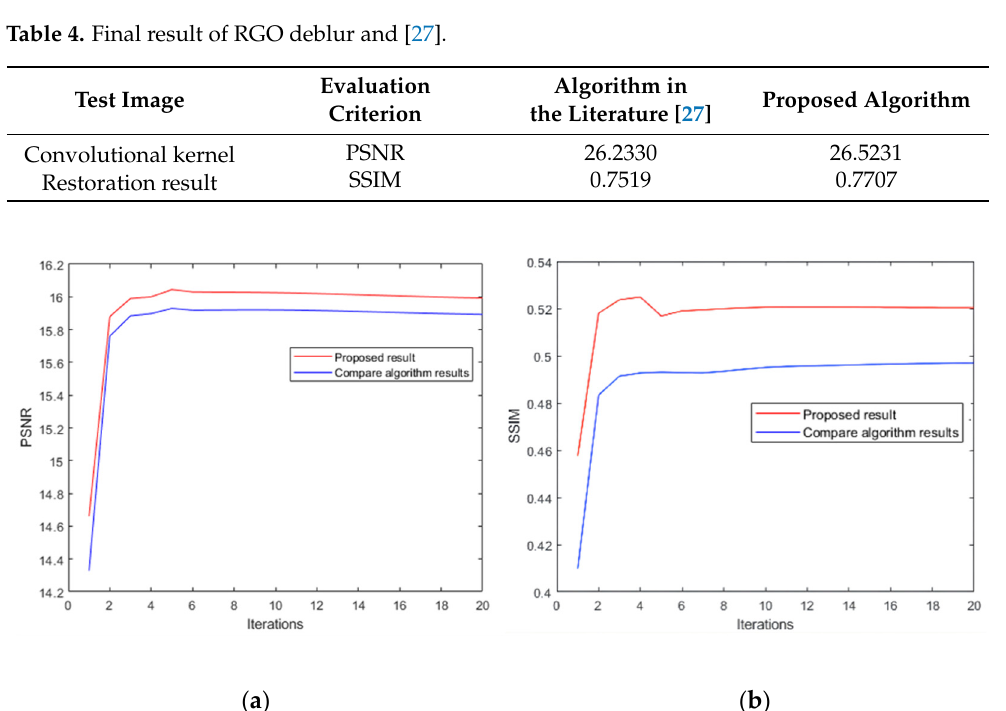
Figure 5. Comparison of iteration: ( a ) PSNR result of difference; ( b ) SSIM result.